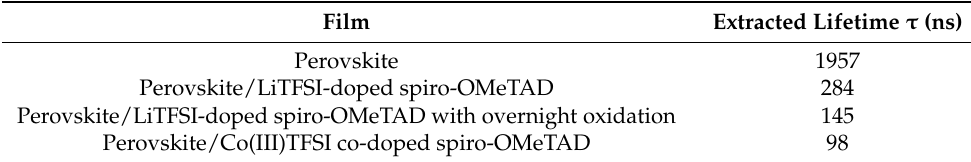
Table 2. Carrier lifetimes extracted from the TRPL spectra for LiTFSI-doped spiro-OMeTAD and Co(III)TFSI co-doped spiro-OMeTAD under different oxidation